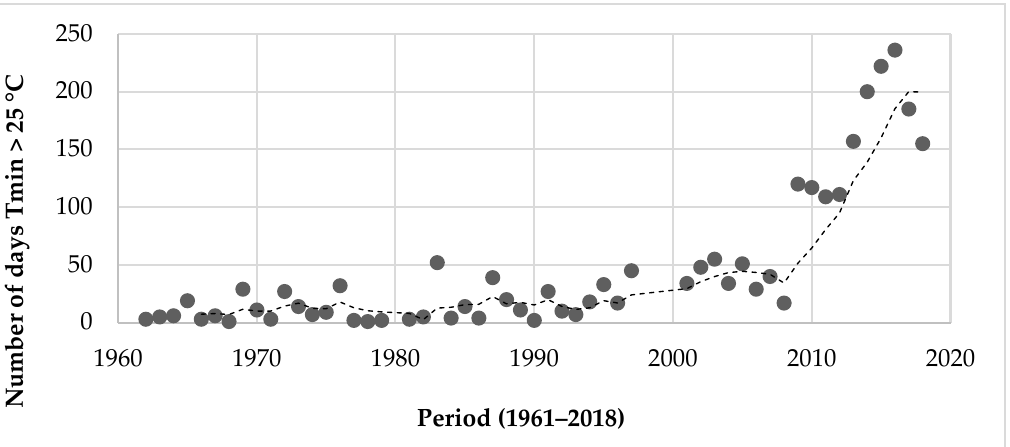
Figure 8. Temporal distribution of the index of the number of annual days with minimum temperature above the 90th percentile (25 °C) in the period from 1961 to 2018. Data from INMET station 82331, 2020. Elaborated by authors.